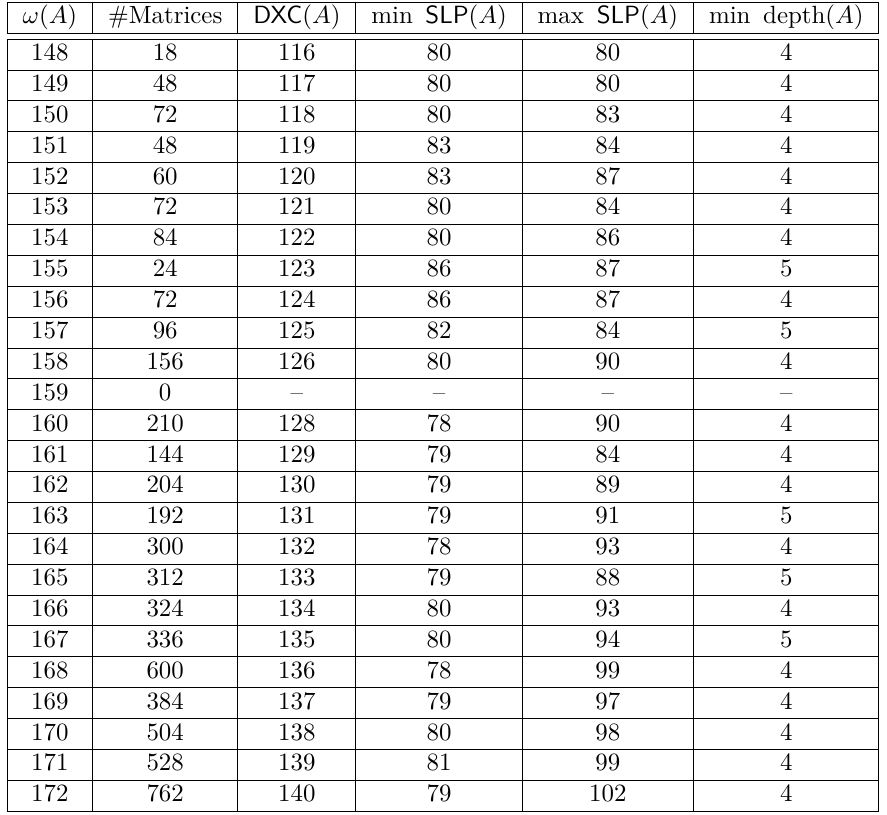
Table 3: A summary of the result. The first row means that we identify a set of 18 matrices whose Hamming weight and DXC are 148 and 116 respectively. The maximal and minimal XOR gate counts of these matrices after applying Boyar’s SLP heuristic are 80, and the minimum circuit depth is